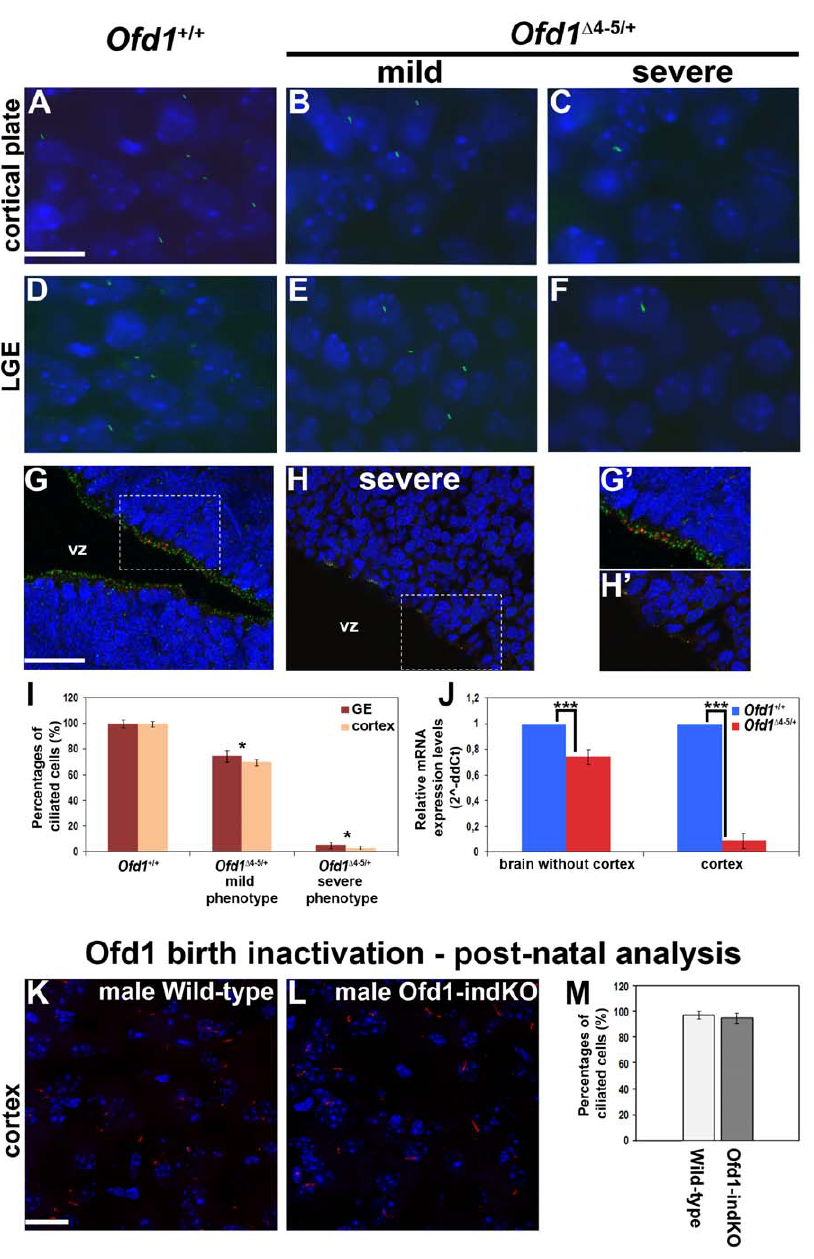
Figure 5. The number of neuronal cilia is reduced in Ofd1 mutant embryos at E12.5 while cilia are not affected upon Ofd1 inactivation at E18.5. A–J. Immunofluorescence analysis by anti-Adenylyl cyclase type III (green) in Ofd1 + / + wild-type embryos (A, D), Ofd1 D 4–5/ + heterozygous females with a mild phenotype (B, E) and in Ofd1 D 4–5/ + heterozygous females with a severe phenotype (C, F) at E12.5. Nuclei are counterstained with DAPI (blue). In both the cortical plate (A, B, C) and the lateral ganglionic eminences (LGE) (D, E, F) the number of cilia is dramatically reduced in embryos with a severe phenotype (C, F). Scale bars: 10 m m. Immunofluorescence analysis by anti-Adenylyl cyclase type III (green labels the cilium) and anti- c tubulin (red labels the basal body) specific for centrosomes in Ofd1 + / + wild-type embryos (G), and in Ofd1 D 4–5/ + heterozygous females with a severe phenotype (H) at E12.5. Dashed rectangles designate enlarged areas indicated in panels G 9 and H 9 showing primary cilia at the ventricular surface of the dorsal telencephalon (G 9 , H 9 ). Histograms indicate the percentage of ciliated cells in the cortex and in the GE (I). In both cases the number is significantly reduced in the severe phenotype at E12.5. Asterisk (*) denotes statistically significant changes with p , 0.05. Quantitative RT-PCR is performed upon mRNA extraction from E12.5 brain. The analysis is performed on isolated cortex and on the remaining part of the brain (J; *** p , 0.01, Student’s test). Error bars indicate standard error of the mean. K–M. Immunofluorescence analysis by anti-Adenylyl cyclase type III (red) in male wild-type mice (K) and male Ofd1-indKO mice (L) at P30. Nuclei are counterstained with DAPI (blue). Neuronal primary cilia are still present in mutant animals analyzed at P30 in which Ofd1 inactivation was induced at E18.5 and. Scale bars: 20 m m. Histograms indicate no difference in the percentages of ciliated cells in male wild-type mice and male Ofd1-indKO mice ( M ).